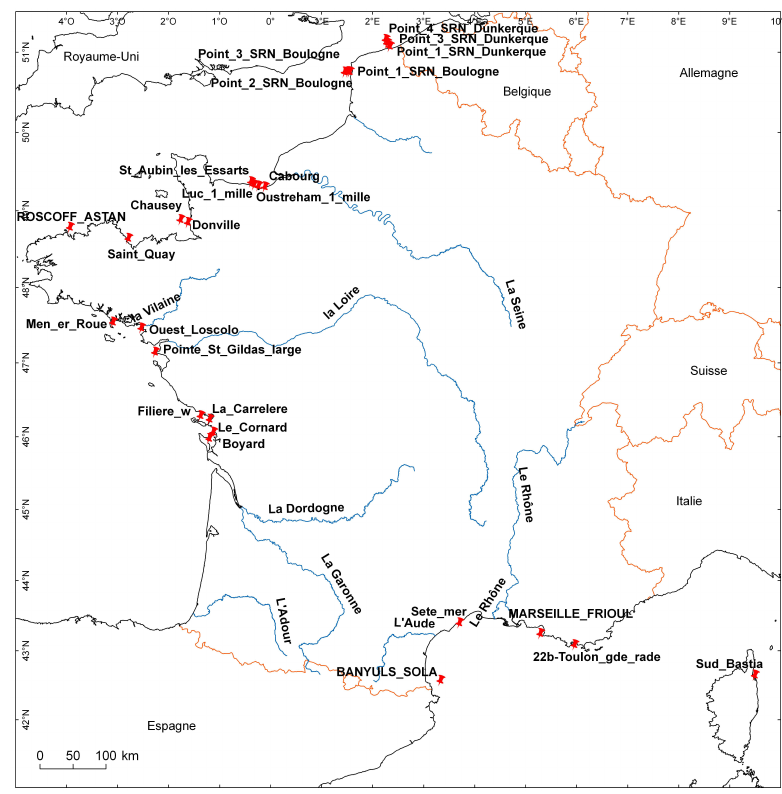
Fig. 1. The 26 stations selected for calibration: The stations have the following codes, from north to south, in the networks: “Point 1 SRN Dunkerque”, “Point 3 SRN Dunkerque”, “Point 4 SRN Dunkerque”, “Point 1 SRN Boulogne”, “Point 2 SRN Boulogne”, “Point 3 SRN Boulogne”, “Cabourg Shifted”, “Luc 1 mille”, “Ouistreham 1 mille”, “St Aubin les Essarts”, “Chausey”, “Saint